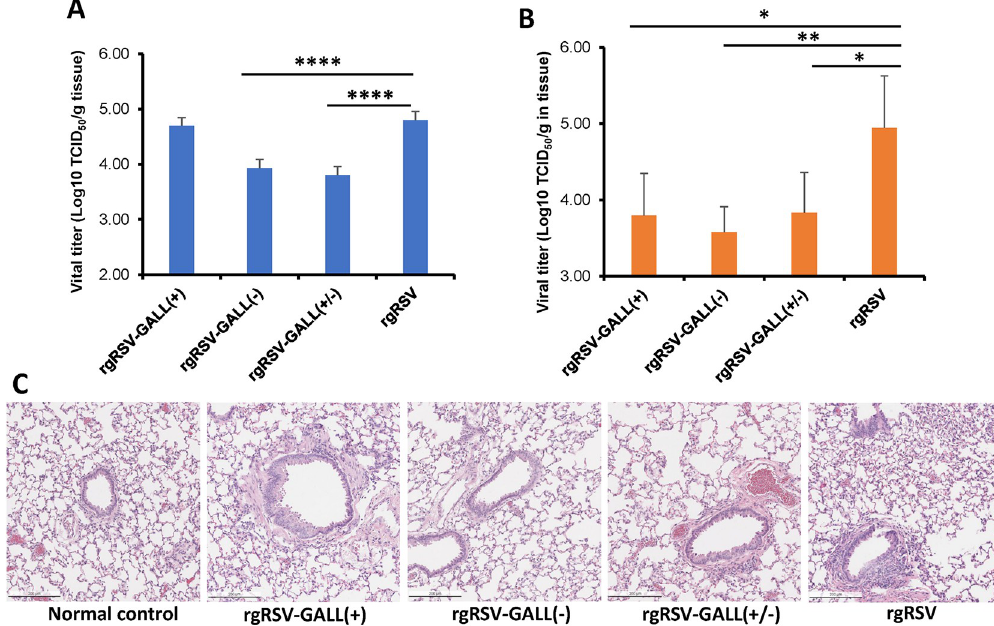
Fig 10. Replication of m 6 A-deficient rgRSVs in cotton rats. (A-B), Replication of rgRSV mutants in cotton rats. Four-week- old SPF cotton rats were inoculated intranasally with 2.0 × 10 5 TCID 50 of each rgRSV. At day 4 post-infection, the cotton rats were sacrificed, and lungs (A) and nasal turbinate (B) were collected for virus titration by TCID 50 assay. (C), Lung histology from RSV-infected cotton rats. Hematoxylin-eosin (HE) staining of lung tissue was shown. Histological images were taken under light microscopy. Micrographs with × 20 magnification (scale bar of 500 μ m) are